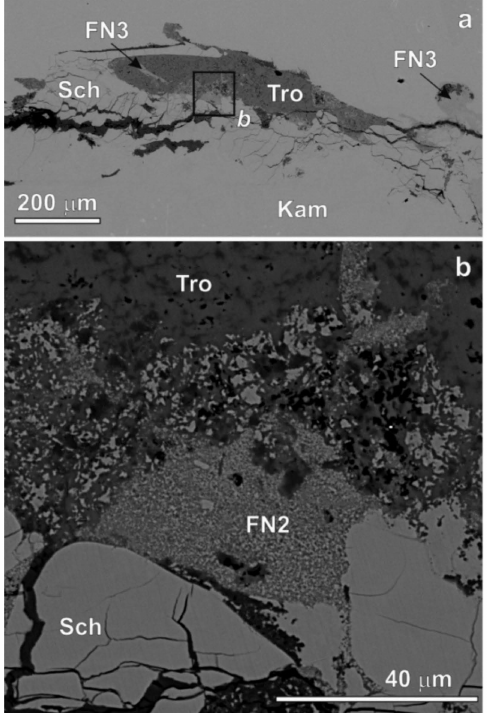
Figure 8. Sites 15 and 19, FN2 at the boundary between troilite (Tro) and schreibersite (Sch). Troilite contains nanocrystalline inclusions of FN3. See Table S1 for chemical compositions (Site 19).